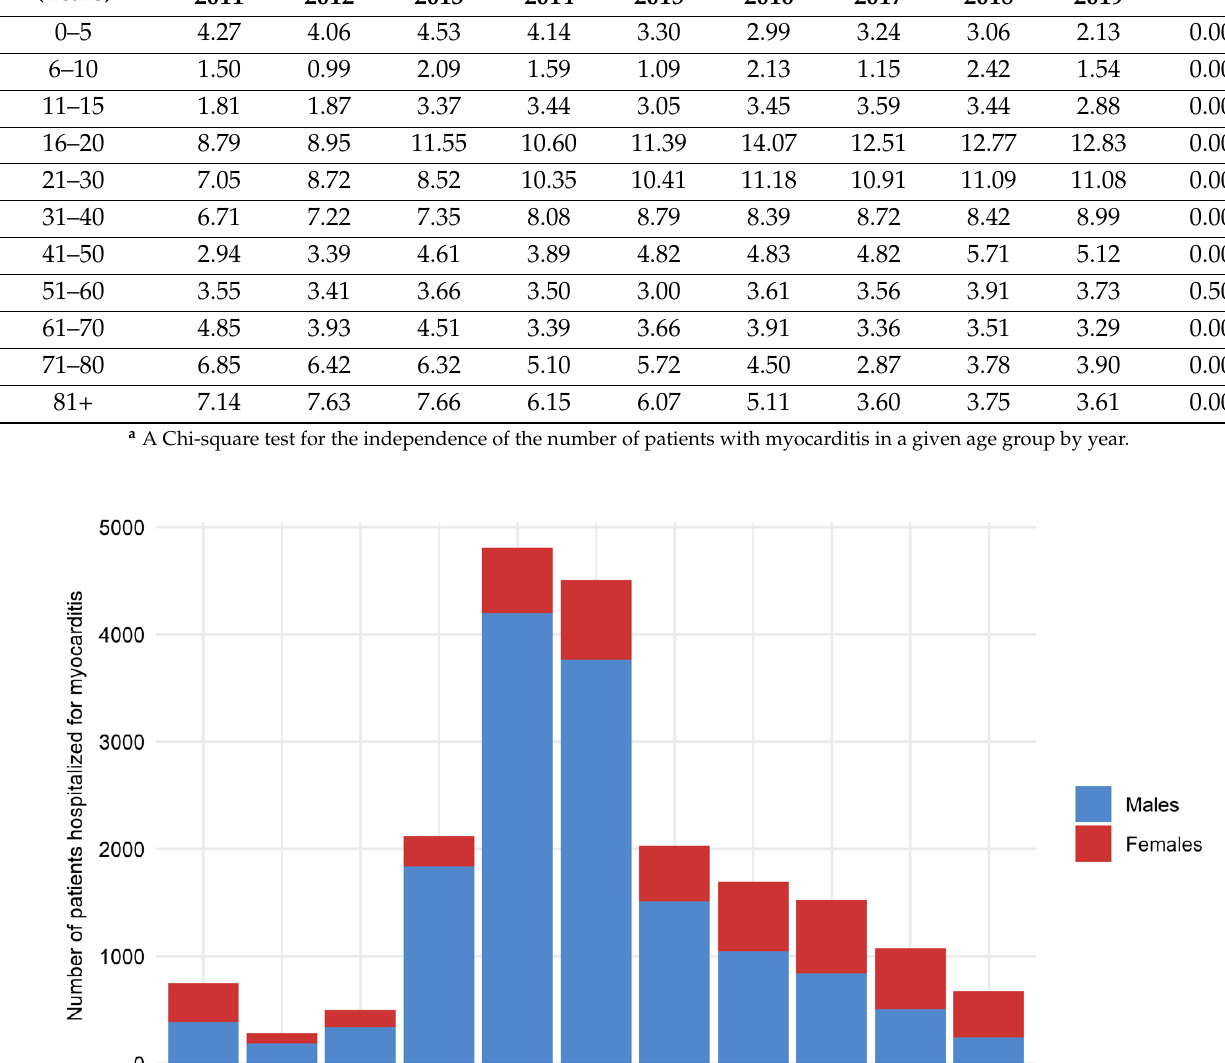
Figure 2. Age-standardized hospitalization rates for myocarditis of males and females by the number of residents in Poland in the years 2011–2019. Most of the clinical characteristics differed between patients aged ≤ 20 and >20 years. Chronic diseases, except for a history of asthma, were more common in the older group. Diagnoses of otolaryngologic and ophthalmic or digestive infectious disease in the prior 6 months were observed more frequently in the younger group. Patients aged ≤ 20 years were